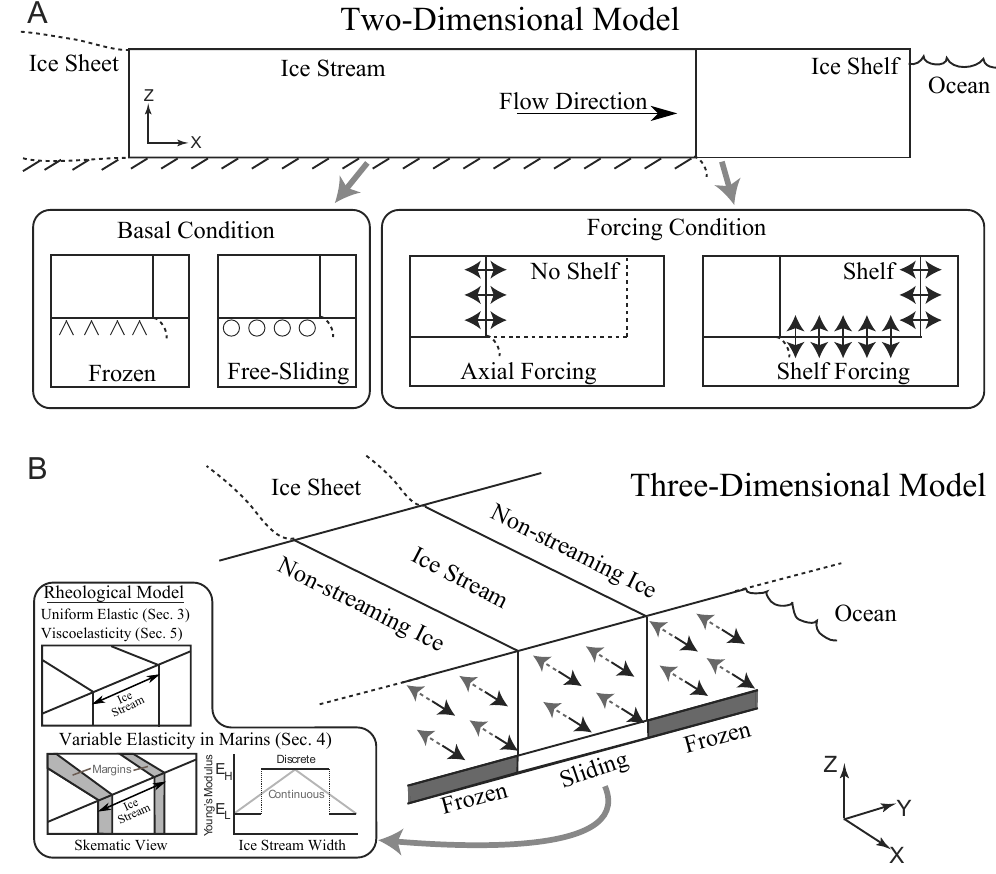
Figure 2. Schematics of the models described in this paper. Inset boxes show options used in each model. For the 2-D models, these options are either a frozen ( u x = u z = 0) or free-sliding ( u z = 0) basal condition with or without an ice shelf. For the 3-D models, we use the same model geometry with variable rheologies: homogeneous linear elasticity, marginal regions of variable elasticity, or Glen-style